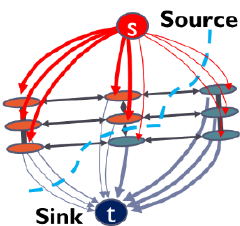
Figure 1.A graph-cut (Adapted from Boykov and Veksler,